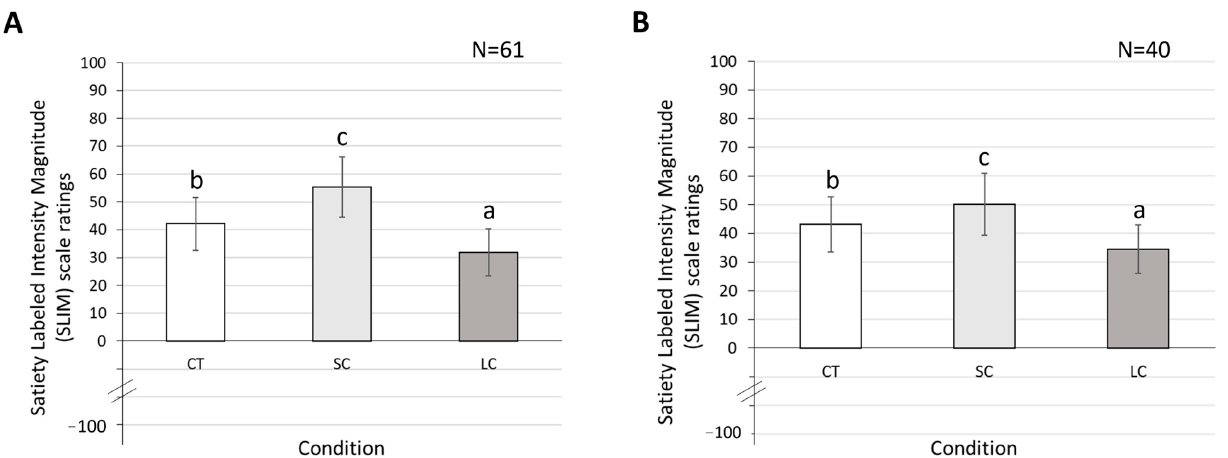
Figure 2. Effect of the jar size condition (CT, SC, LC) on Satiety Labelled Intensity Magnitude (SLIM) scale ratings based on 61 (panel ( A )) or 40 participants (panel ( B )). Error bars represent standard deviations. Assigned letters in the figure indicate significant differences ( p < 0.05) across the conditions.